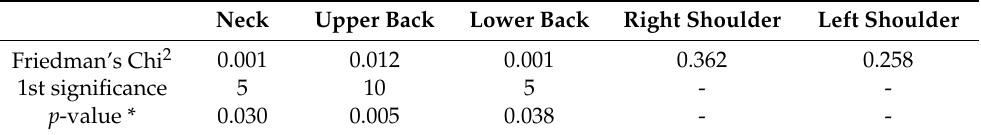
Table 3. Results for the first significance of pain reduction. Friedman test with multiple comparisons between the 1st, 5th, 10th, 15th and 20th training units was applied. The row “1st significance” indicates the first significant comparison obtained between the first and subsequent training